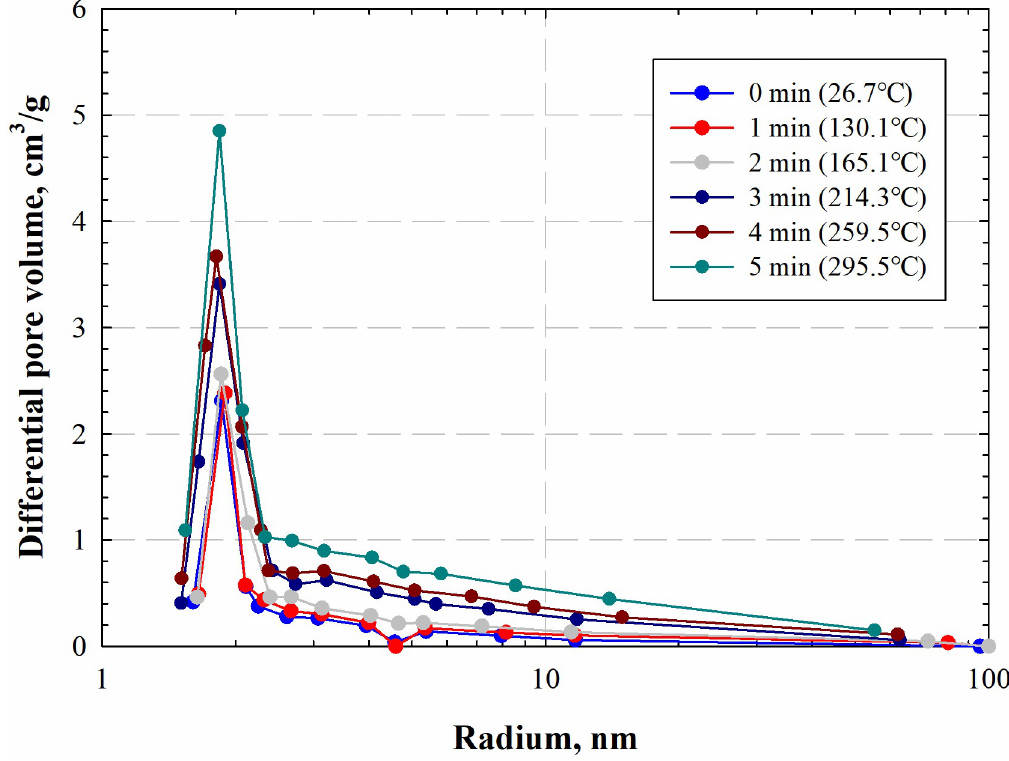
Fig 7. Pore-size distributions of marine shale samples obtained at different electromagnetic radiation